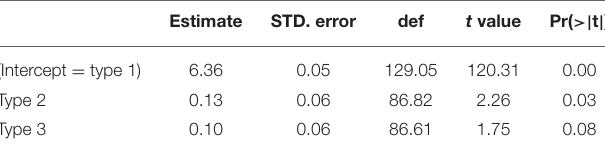
TABLE 12 | Linear regression analysis of the response latencies of the judgements to correctly accepted words in experiment